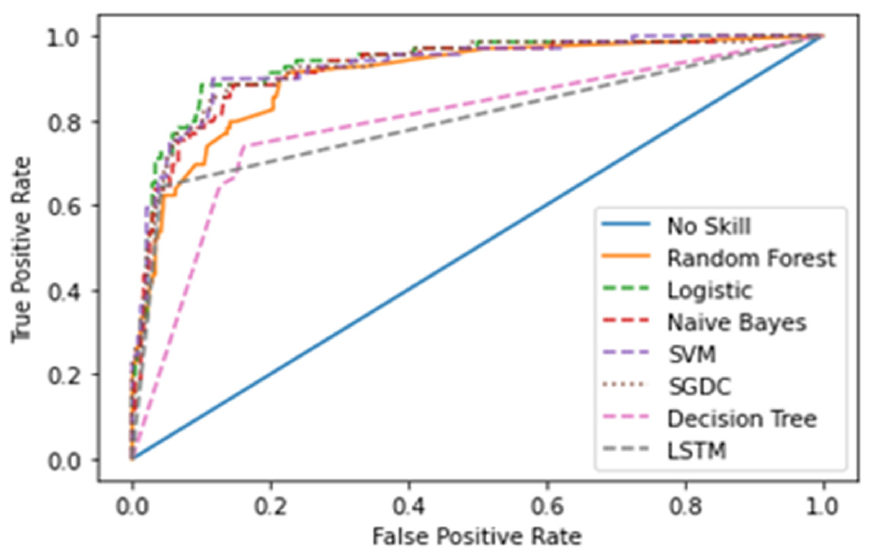
Figure 16. ROC curve for the second Figure 16 . ROC curve for the second dataset. Figure 16 . ROC curve for the second dataset.